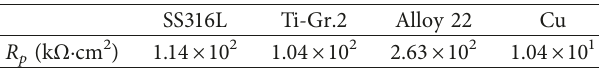
Table 3: R p values of SS316L, Ti-Gr.2, Alloy 22, and Cu exposed to chloride-added KURT groundwater